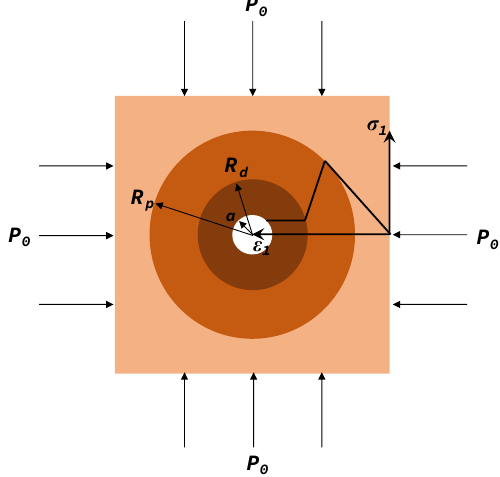
Figure 1. Elastic-strain softening model.